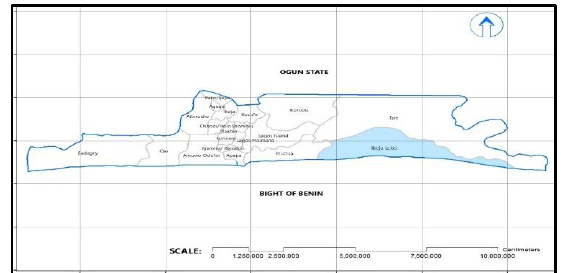
Figure 1. Map of Lagos State showing Ibeju-Lekki (study area highlighted in blue). Source: Field Survey,